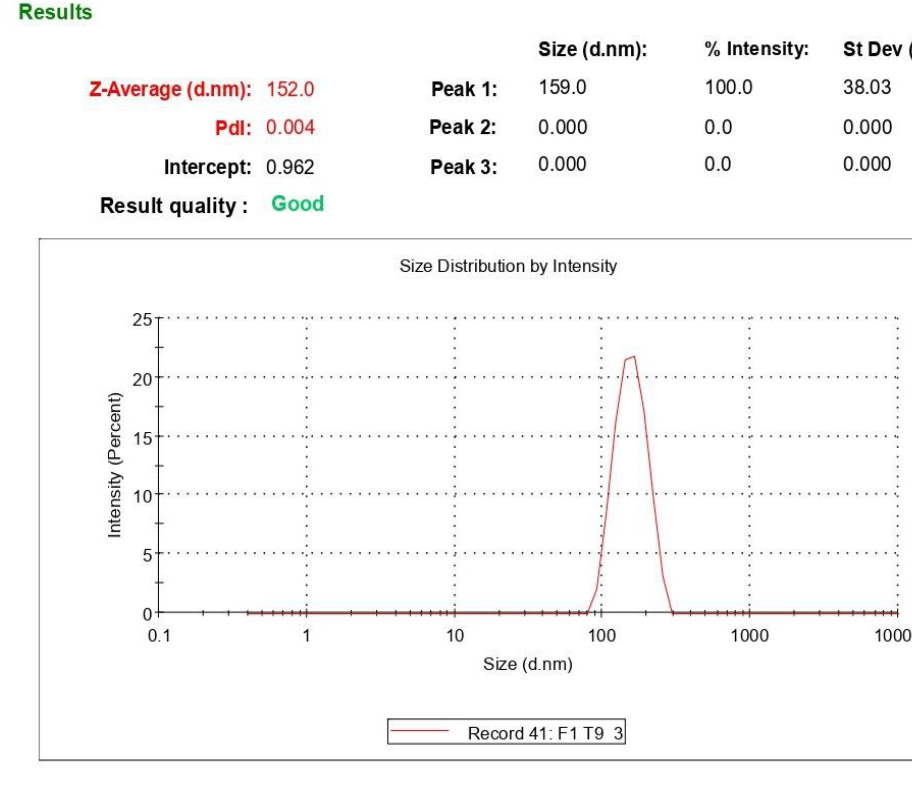
1: Free PEGylated nanophytosomes. 2: PEGylated nanophytosomes loaded with 6-gingerol. All data